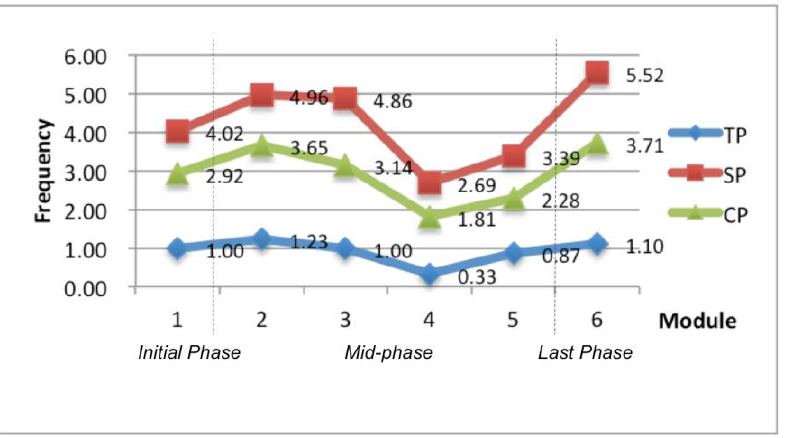
Figure 3. Average number of student's social, teaching and cognitive presence posts in each module. A closer examination of students’ cognitive presence is shown in Figure 4 . The Exploration (EX) dimension of cognitive presence was the highest, followed by the Integration (IN) dimension. Dimensions of Resolution (RE) and Triggering Event (TE) were low. The fact that no special scaffolds were designed for Triggering Event in the first iteration might result in the low value of triggering event. Resolution as a dimension of cognitive presence remained low